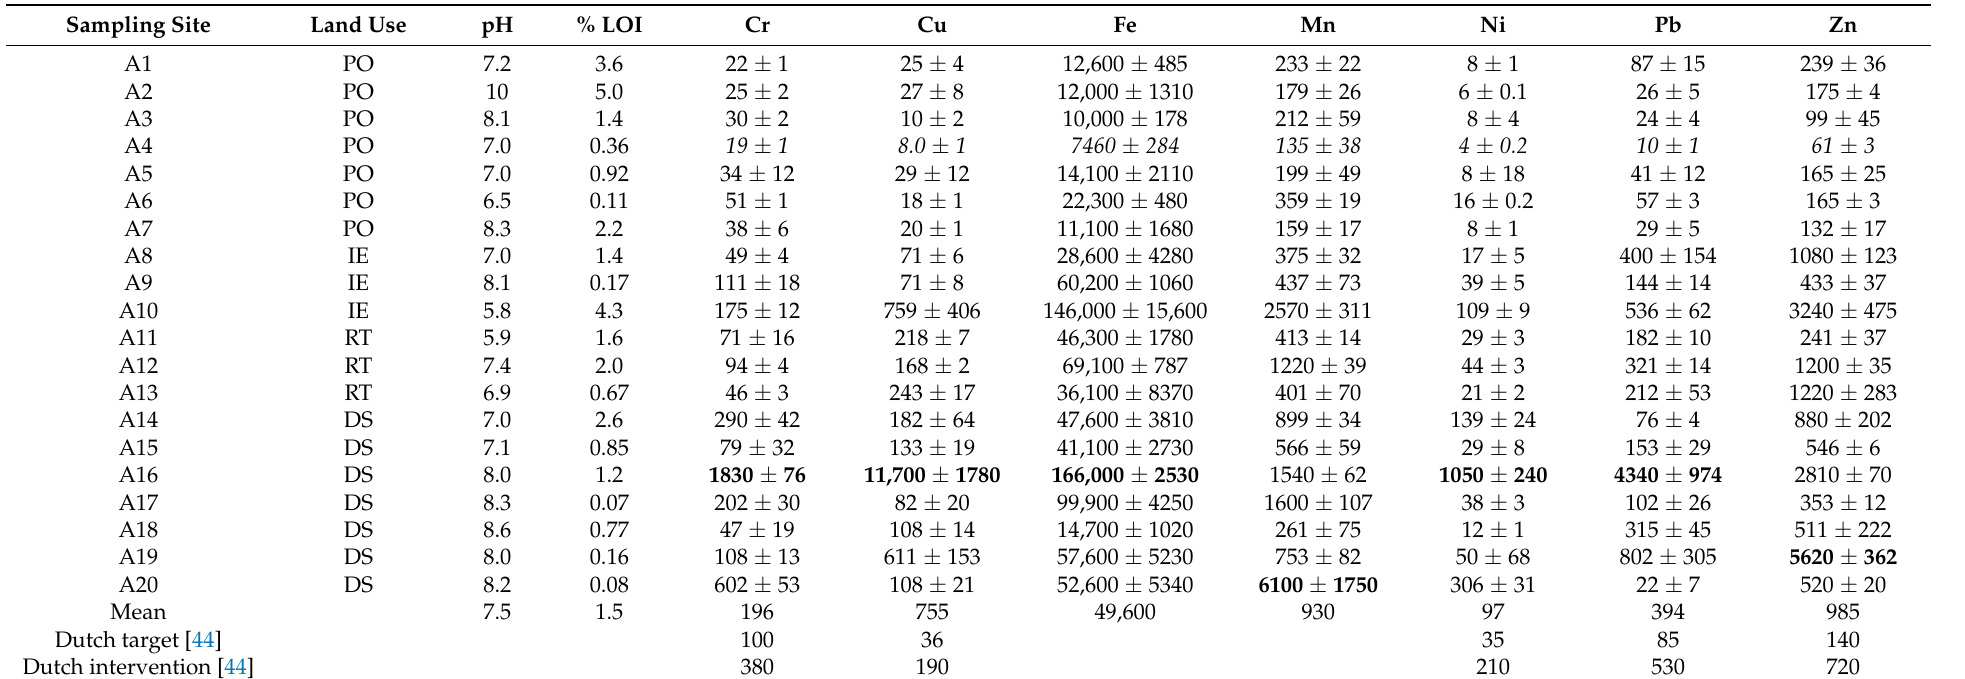
Table 4. Pseudo-total PTE concentrations in Lagos urban soils (mg/kg dry